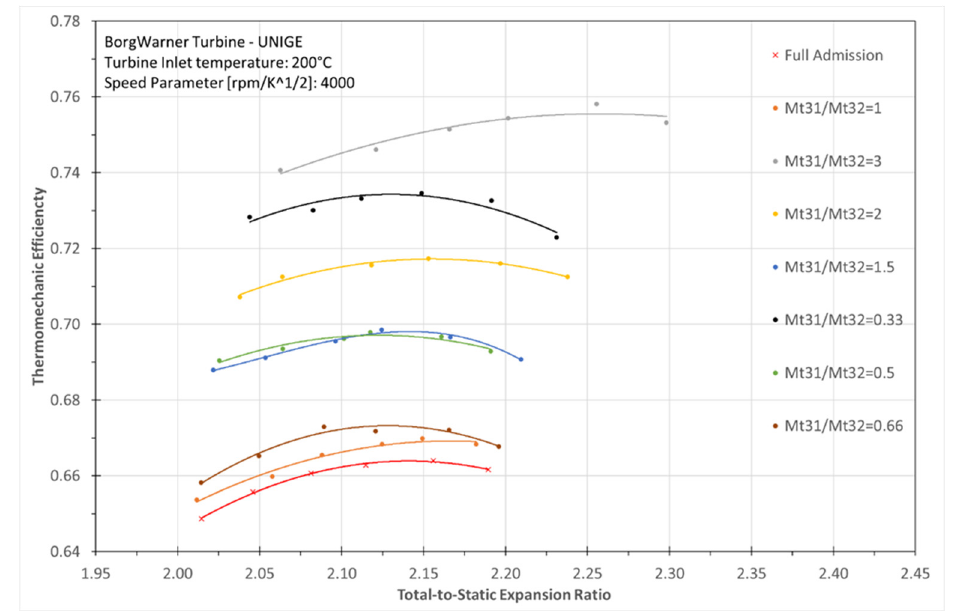
Figure 12. Thermomechanical efficiency vs. expansion ratio at different admission conditions at (cid:104) rpm (cid:105) √ N t = 4000 K